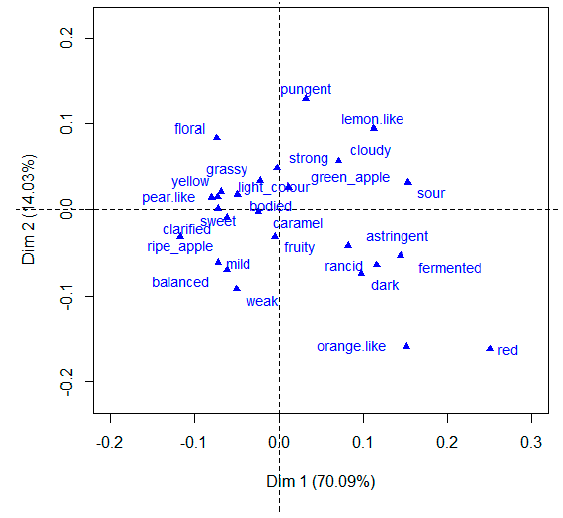
Figure 9. Multiple factor analysis plot of descriptors selected through the classic approach. Foods 2019 , 8 , x FOR PEER REVIEW